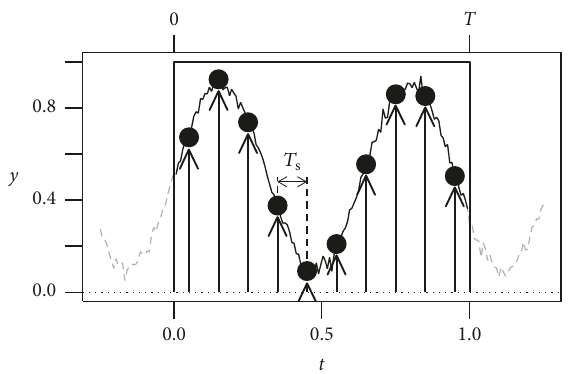
Figure 1: The arbitrary signal with overlapped normal distributed noise 𝑝(𝑡) = 0.4 cos (2𝜋⋅1.5𝑡−𝜋/2)+ N (0, 0.02)+0.5 is shown here. It is only within the rectangular window that the measurement takes place and the signal 𝑠(𝑡) can exist. Outside this window the physical process might go on but is not recognized anymore. The points and arrows mark the sampling of that